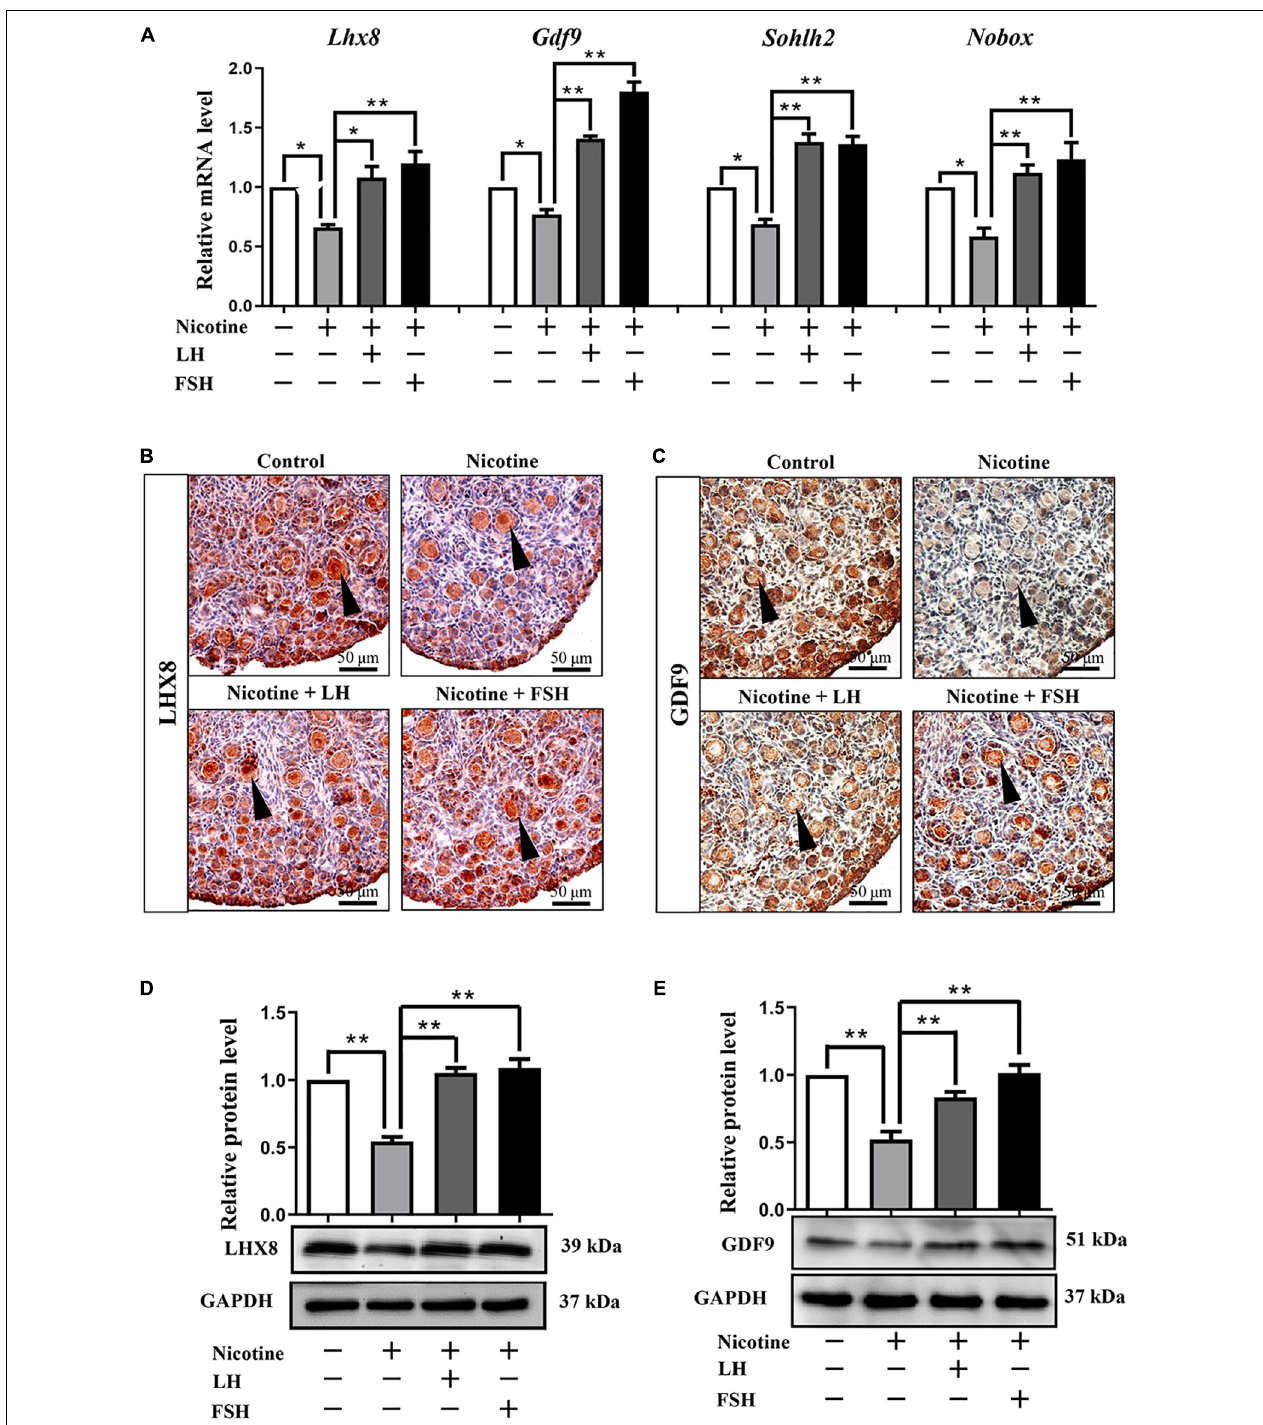
FIGURE 2 | LH and FSH counteract the decreased expression of oocyte-specific transcription factors in nicotine-exposed ovaries. (A) Quantitative real-time PCR (RT-qPCR) for Lhx8 , Gdf9 , Sohlh2 , and Nobox mRNA levels in control, nicotine, and nicotine plus LH or FSH ( n = 36 newborn female pups). (B) Representative images of IHC for LHX8 (black arrow) in tissue sections of the ovaries in each group. Scale bar, 50 µ m. (C) Representative images of immunohistochemistry (IHC) for the GDF9 (black arrow) in tissue sections of the ovaries in each group ( n = 12 newborn female pups in B,C ). Scale bar, 50 µ m. (D) Relative protein level of LHX8 of the ovaries in each group. (E) Relative protein level of GDF9 of the ovaries in each group ( n = 36 newborn female pups in D,E ). The data are presented as means ± S.E. of three independent experiments (each in triplicate). * P < 0.05, ** P < 0.01.